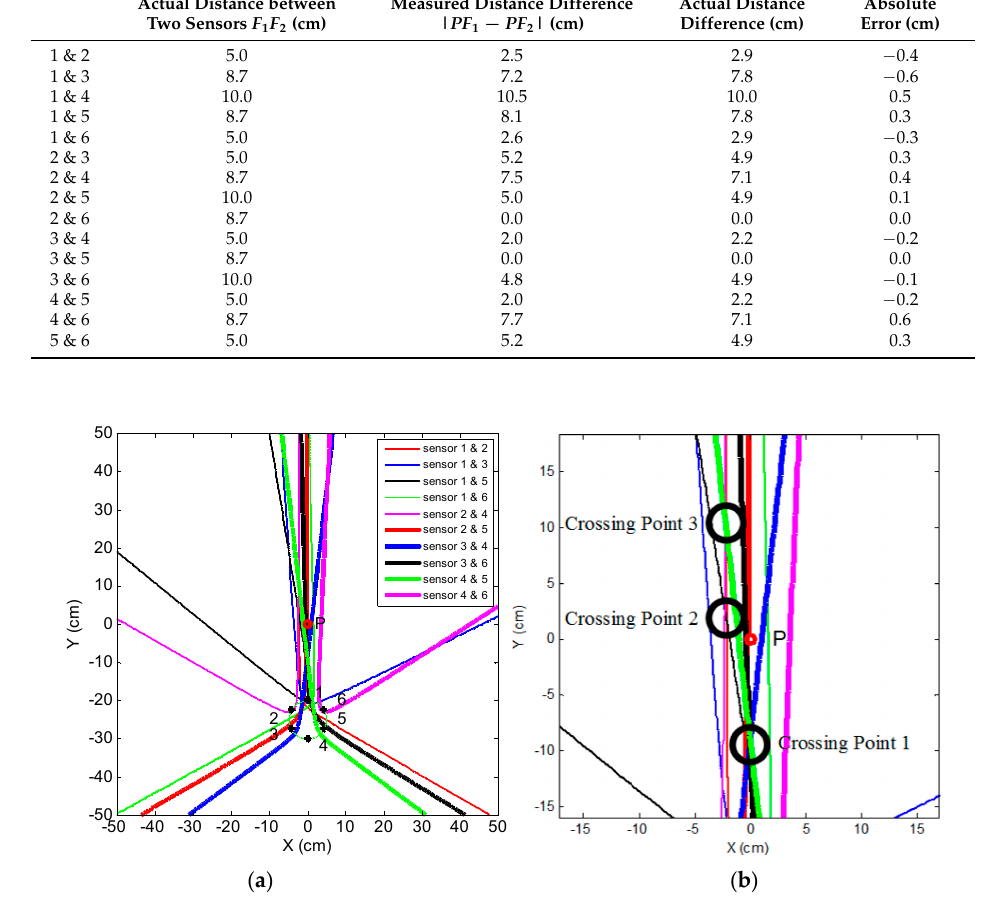
Figure 8. Leak localization result. ( a ) Leak localization plot; and ( b ) a zoomed-in version around the leak hole.